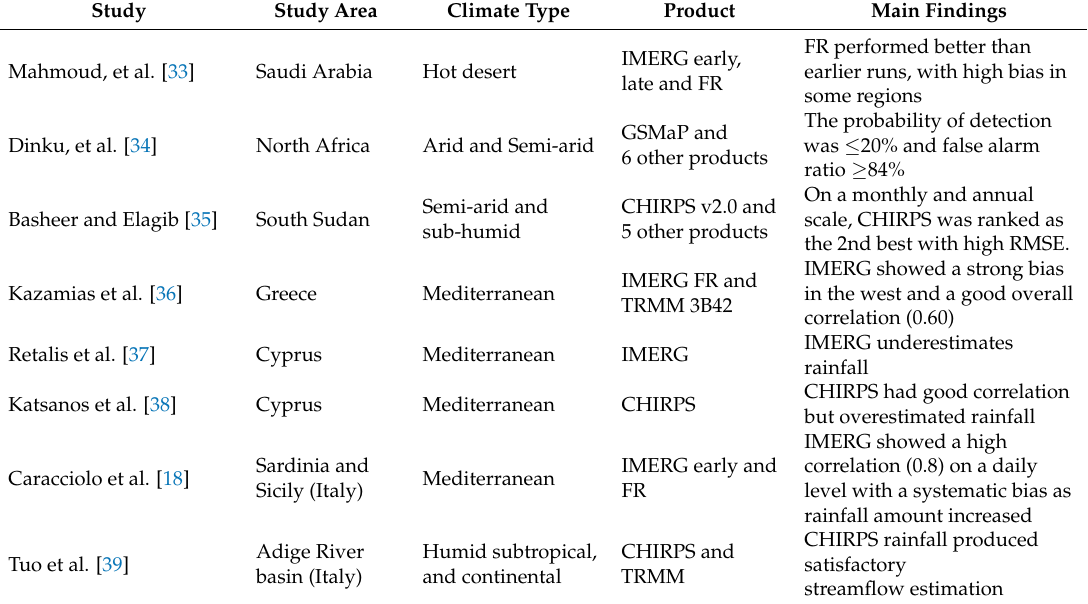
Table 1. Summary of the main findings of the previous studies on the evaluation of satellite-based rainfall products in neighboring countries of